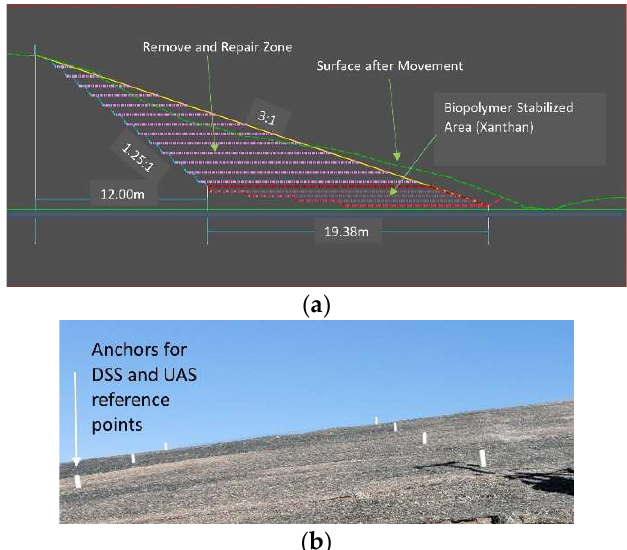
Figure 8. Cross Section and Pictue of Verdigre Slope. ( a ) Retrofitting design of the slope. ( b ) Anchors for DSS and UAS reference points.